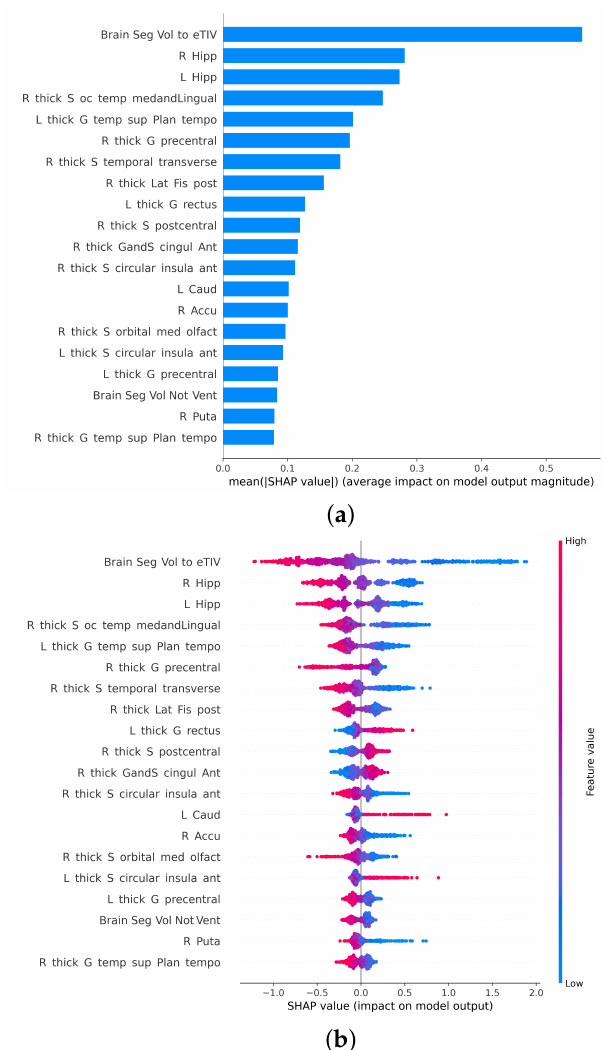
Figure 4. Study of the most important features based on the computation of the SHAP values for each feature and sample of the total of 804 subjects in the test set, both in aggregate ( a ) and for each data point ( b ). The vertical axis of each figure represents the features ranked by importance (top to bottom) calculated as the sum of the SHAP value magnitudes over all samples (horizontal axis). ( a ) Shapley values averaged for all subjects. The most important feature according to the SHAP values is the brain- to-intracranial-volume rate, followed by the volume of the hippocampi. ( b ) Shapley values for each subject. When the point distribution is clustered around 0, it indicates that the feature is unimportant; the more spread the distribution is, the more important the SHAP value is for predicting